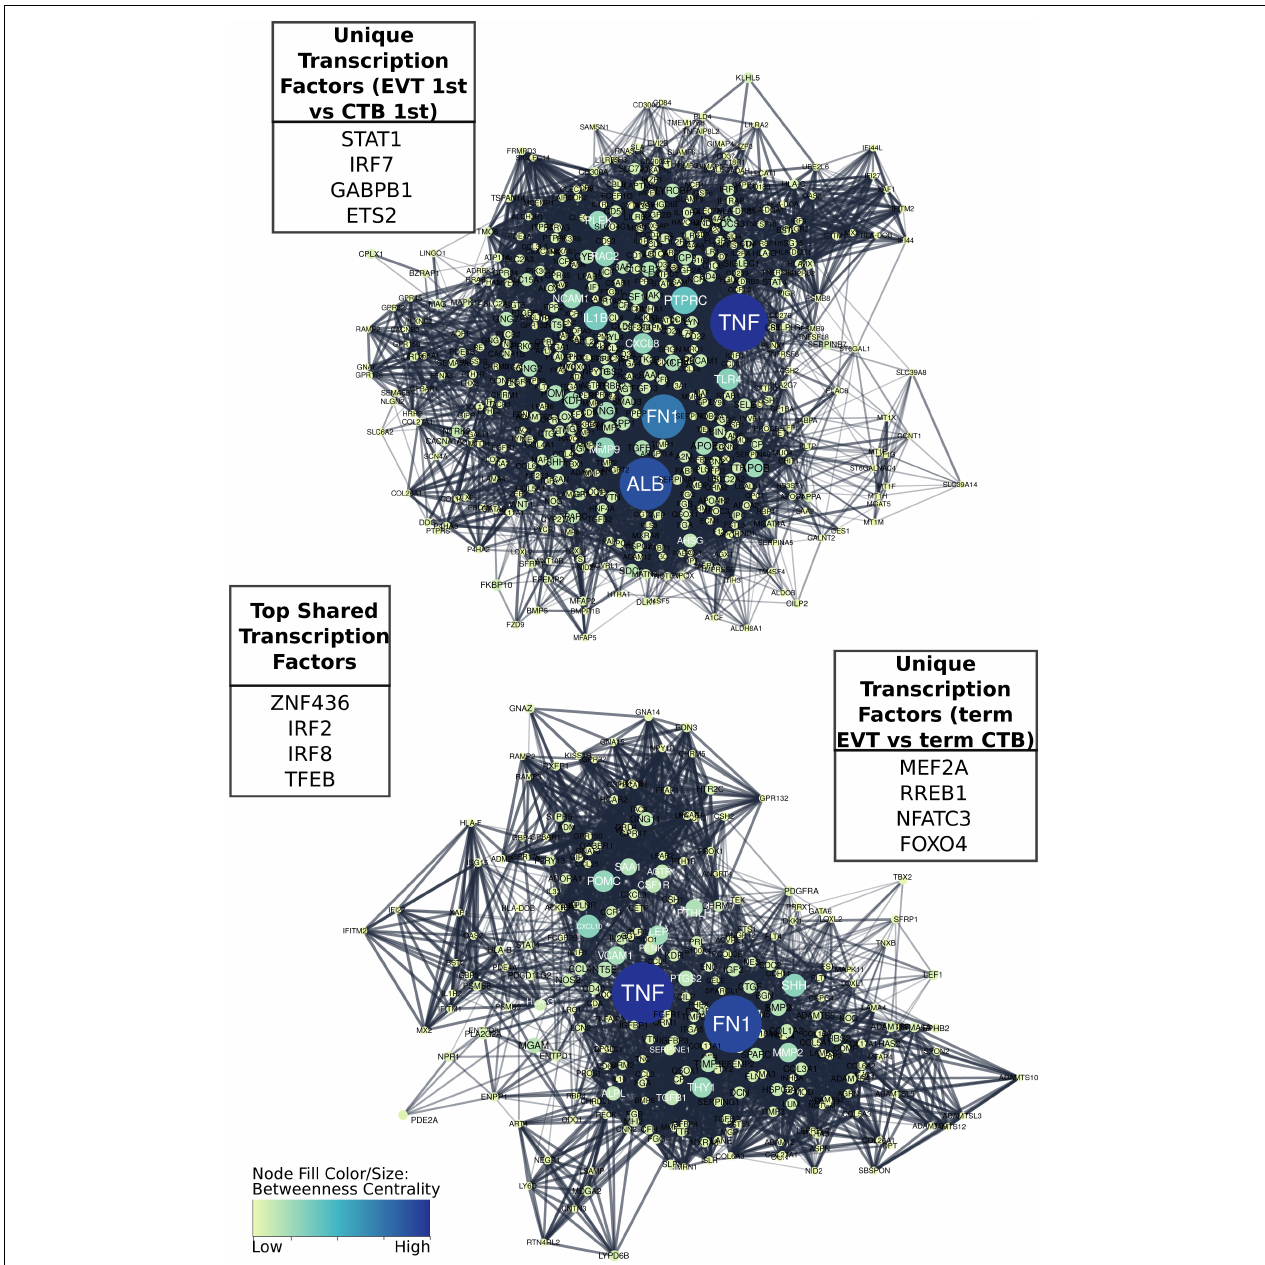
FIGURE 7 | Comparison of gene regulatory networks involved in development of first trimester and term EVT. Networks were created by first generating protein to protein interaction STRING networks of up-regulated genes, either in first trimester EVT compared with first trimester CTB (top), or in term EVT compared with term CTB (bottom), then clustering networks into subnetworks. The largest subnetwork from each comparative analysis is shown. Displayed “unique” transcription factors (TFs; top left and bottom right tables) were those found to have the highest summed importance scores in terms of the labeled subnetwork. Displayed “top shared” TFs (middle table) were the top four transcription factors in terms of importance for both subnetworks. Subnetwork node sizes and colors are determined by the nodes calculated betweenness centrality